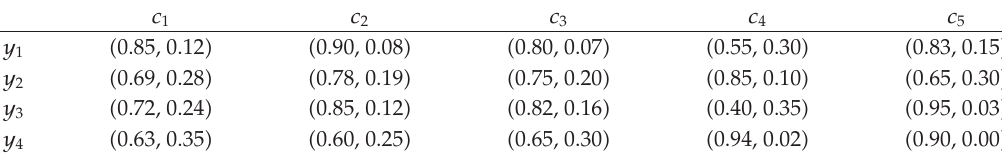
Table 1: Normalization intuitionistic fuzzy decision matrix R (cid:7) (cid:2) r ij (cid:3) c 1